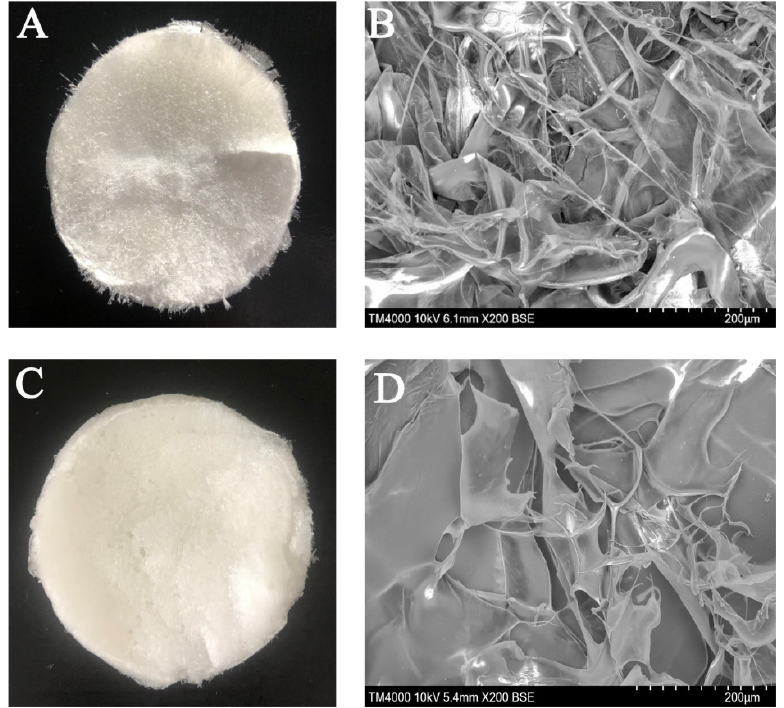
Figure 4. Bactrian camel skin collagen as viewed by the naked eye (( A ): PSC and ( C ): UPSC) and SEM micrograph (( B ): PSC and ( D ): UPSC) (PSC, pepsin-solubilized collagen; UPSC, ultrasound-treated pepsin-solubilized